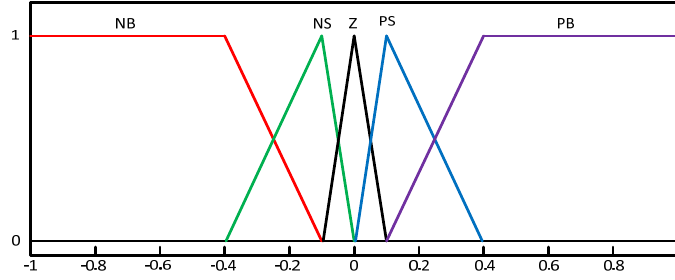
Figure 5. MFs of error and change of error of CFPID. Table 5. Fuzzy rule foundation for CFPID.